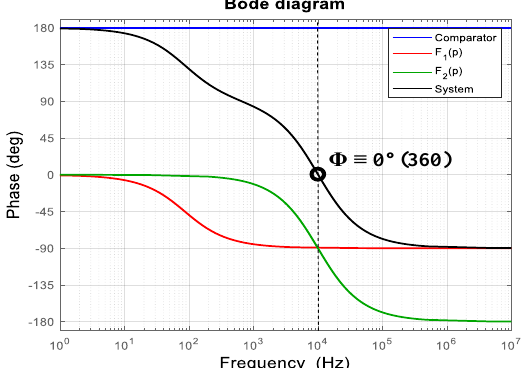
Figure 3. Phase rotation of the system and of each element of the PSSOCC ( 𝑓 𝑜 = 10 𝑘𝐻𝑧)